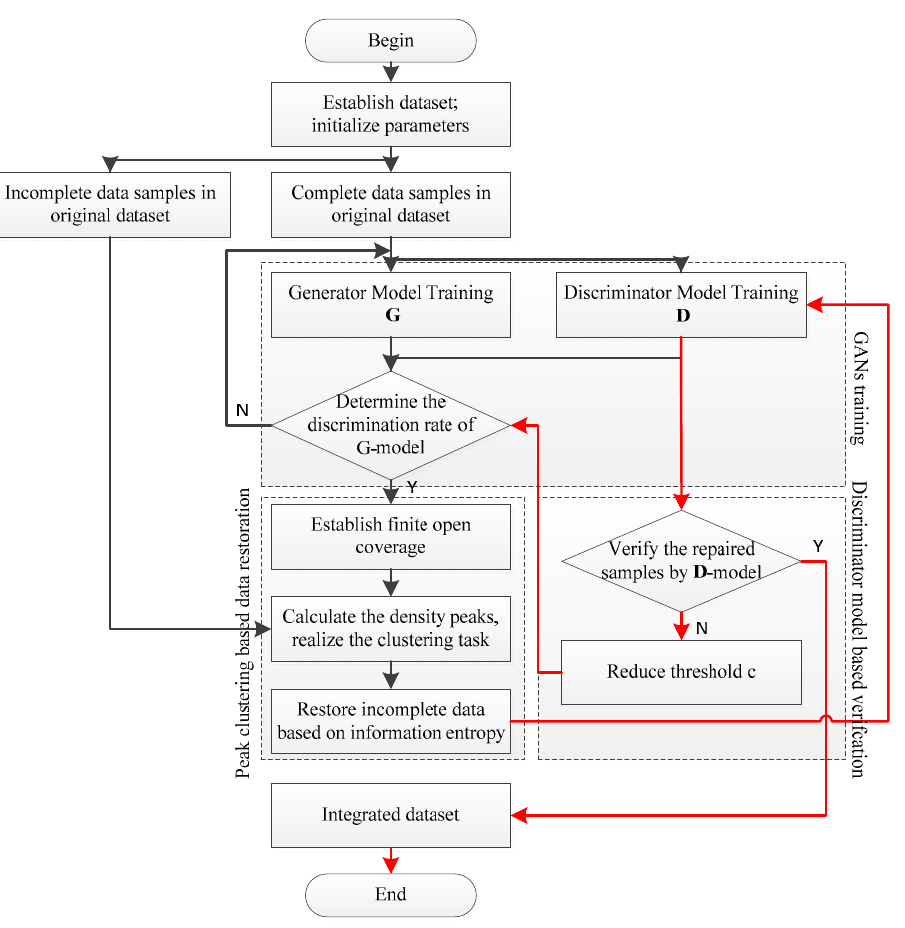
Figure 4. Diagram of GANs based heterogeneous data integration for intelligent power distribution and utilization.